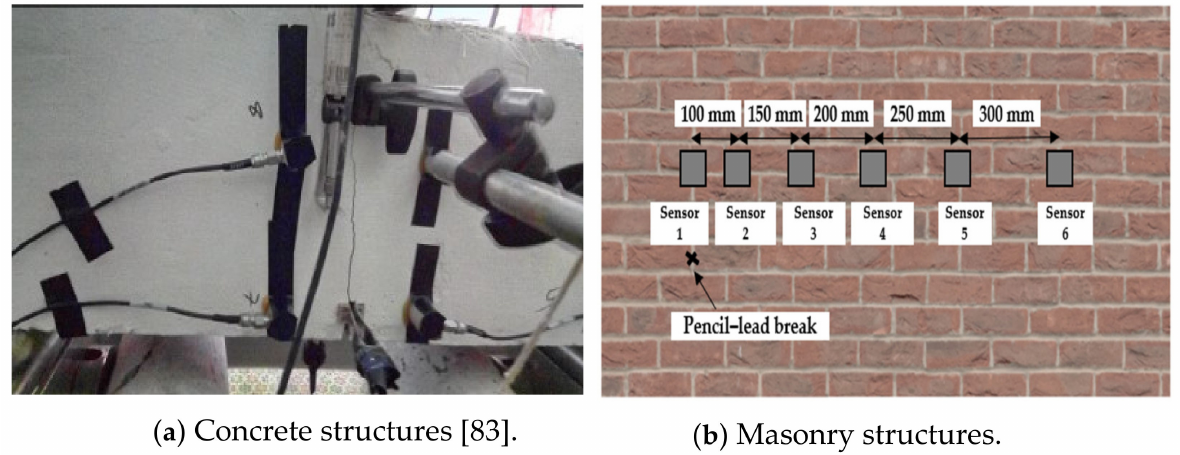
Figure 12. Examples of AE sensors application for crack